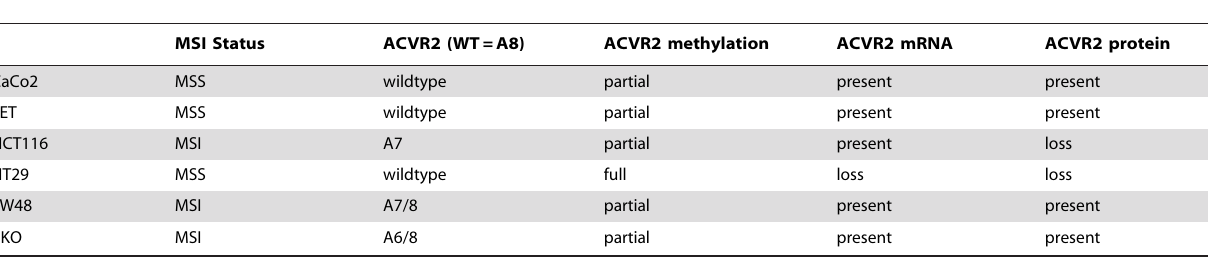
Table 3. ACVR2 expression and mechanisms for loss of expression in colon cancer cell lines.